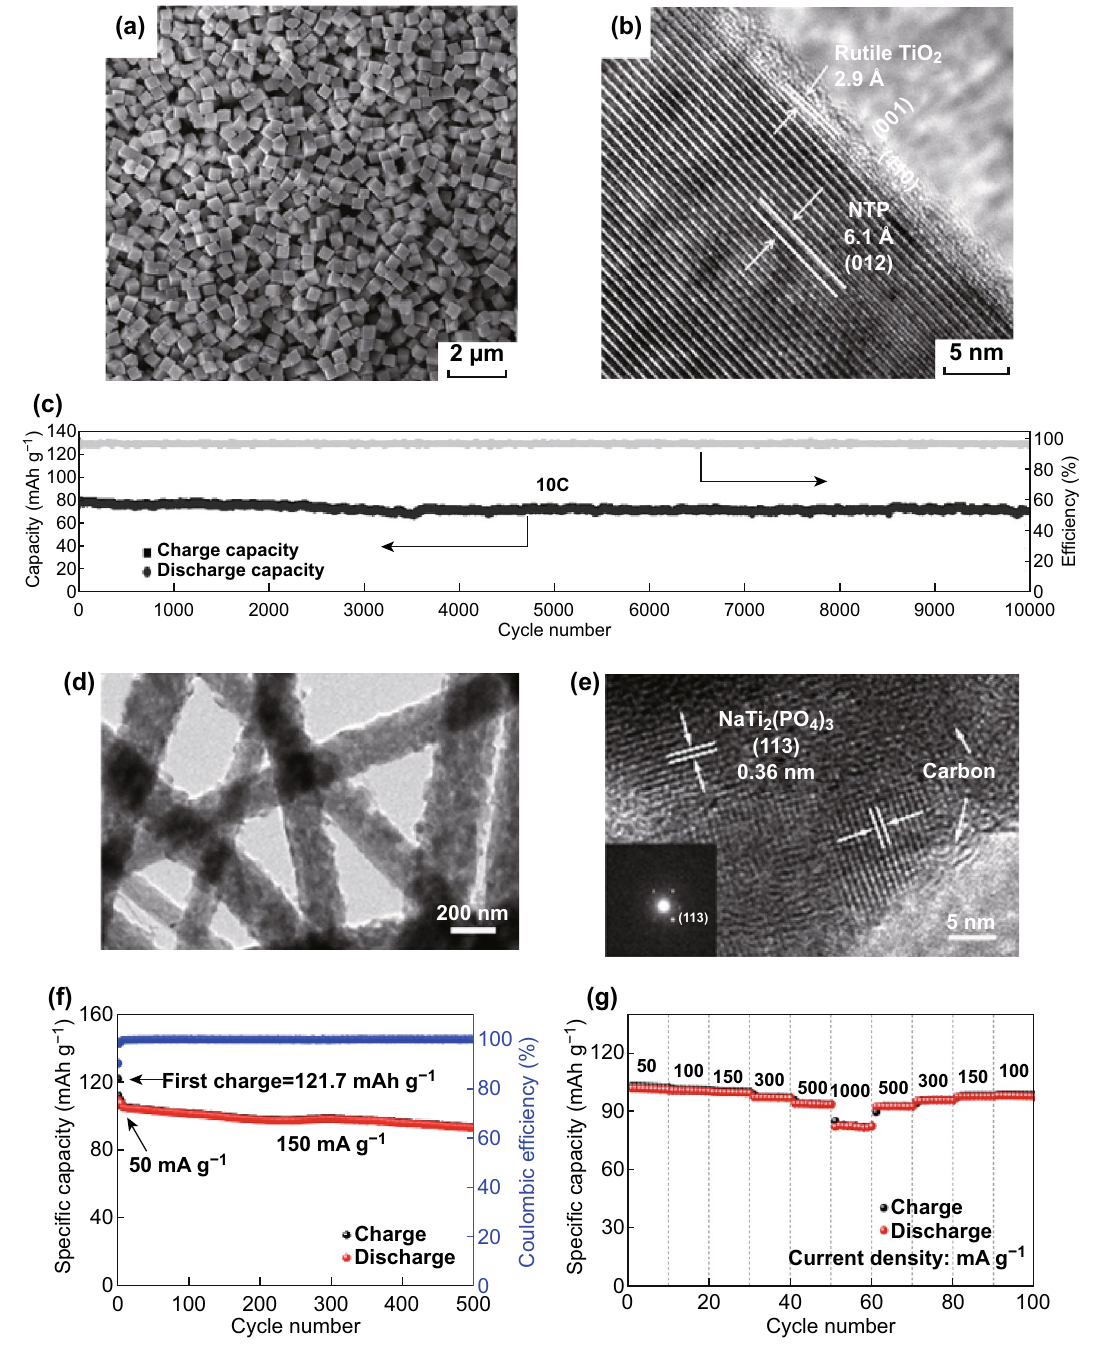
Fig. 5 a SEM image and b HRTEM image of NTP-RT at the edge and c ultralong-term cycling performance at a high current density of 10 C [84]. Copyright 2015, Wiley–VCH Verlag. d, e TEM images at different magnifications. f Cycling stability and g various charge/discharge rates of NTP/CNFs//NiHCF full cell [75]. Copyright 2018, American Chemical